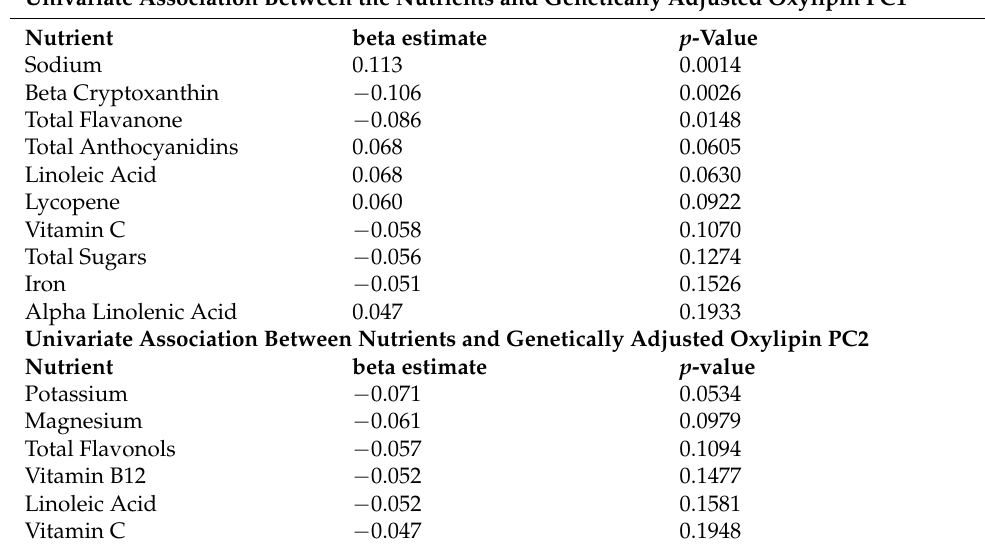
Table 2. Individual associations between the nutrients and oxylipin